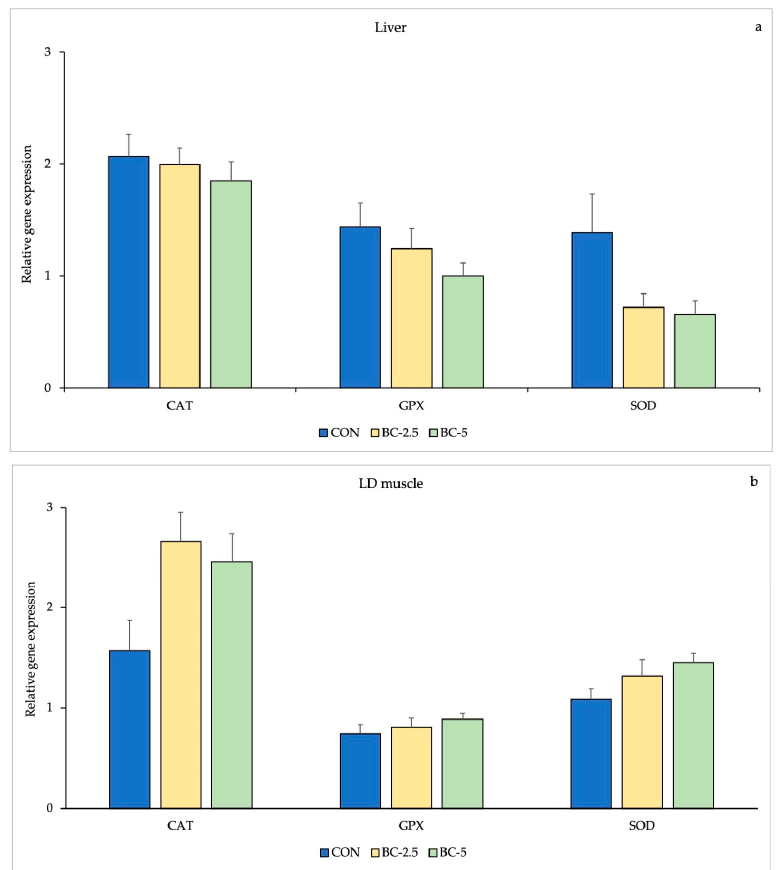
Figure 1. mRNA expression levels of antioxidant enzymes CAT, GPx and SOD in the liver ( a ) and LD muscle ( b ) of rabbits fed diets supplemented with bovine colostrum. The data are reported as means ± SD. CON: group without supplemented diet; BC-2.5: group supplemented with 2.5% of